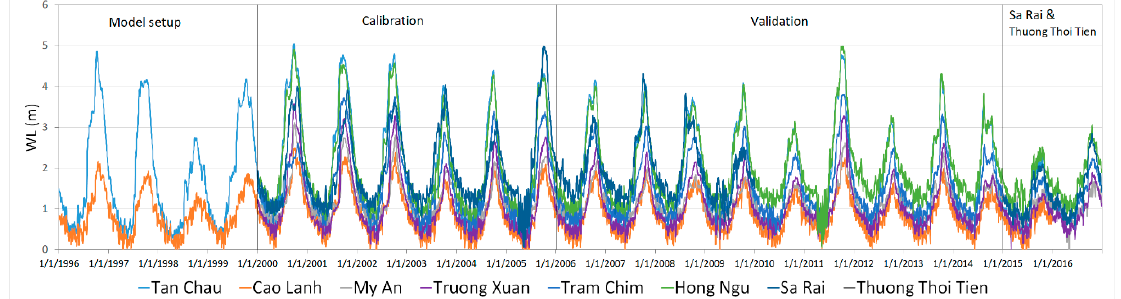
Figure 7. Hydrological data for the Dong Thap HEC-RAS model. WL: water level.